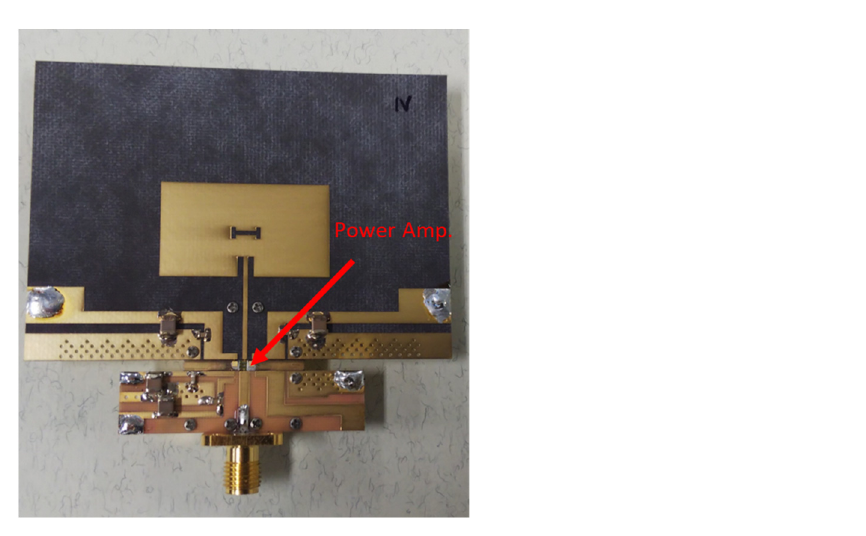
Figure 15. Photograph of the fabricated power-amplifier-integrated antenna.